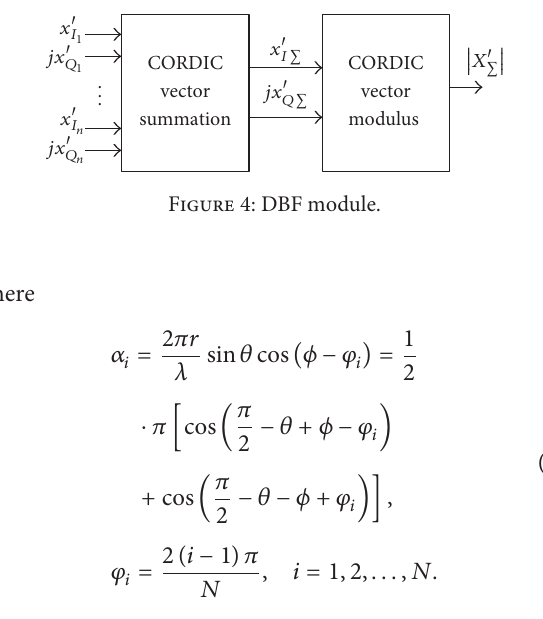
Figure 6: Illustration of circular